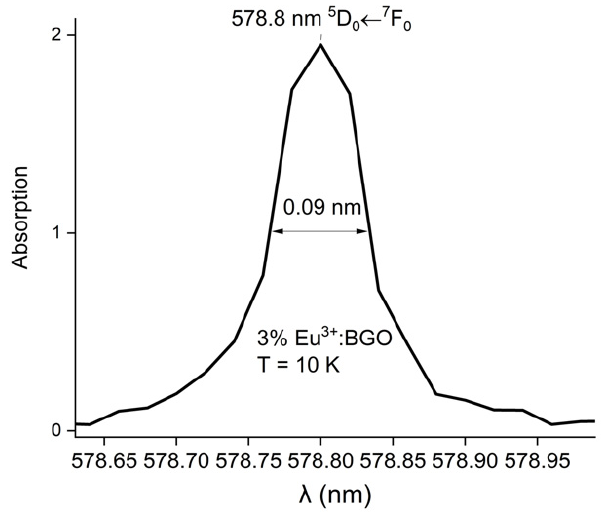
Figure 4. Low temperature (10 K) absorption spectrum where 5 D 0 ← 7 F 0 line is shown.